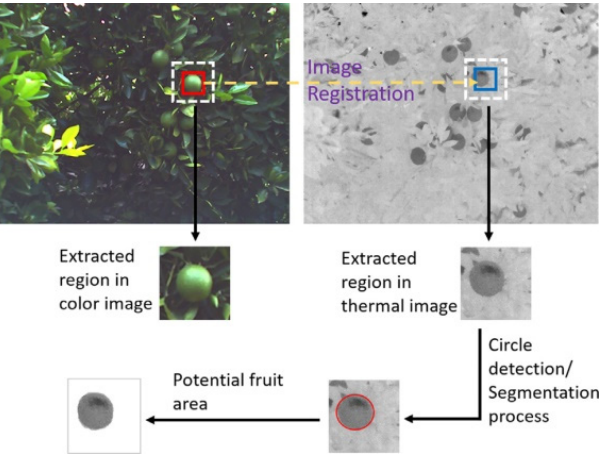
Figure 5. Green orange recognition based on a thermal infrared image (Photo: Reprinted with permission from Ref. [55]. 2018, Gan H.).